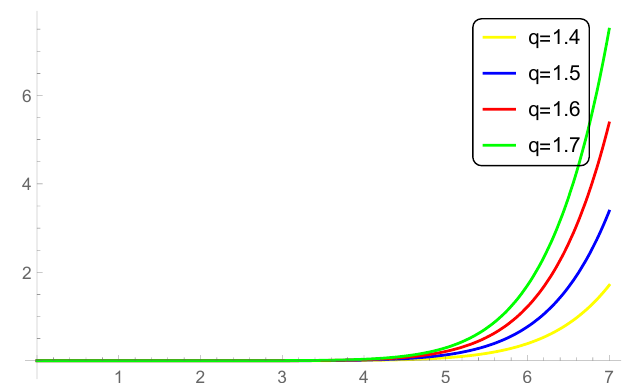
Figure 5. The effect of the delay parameter q on the difference d N ( t )( N = 10 ) at λ = 1 and α =